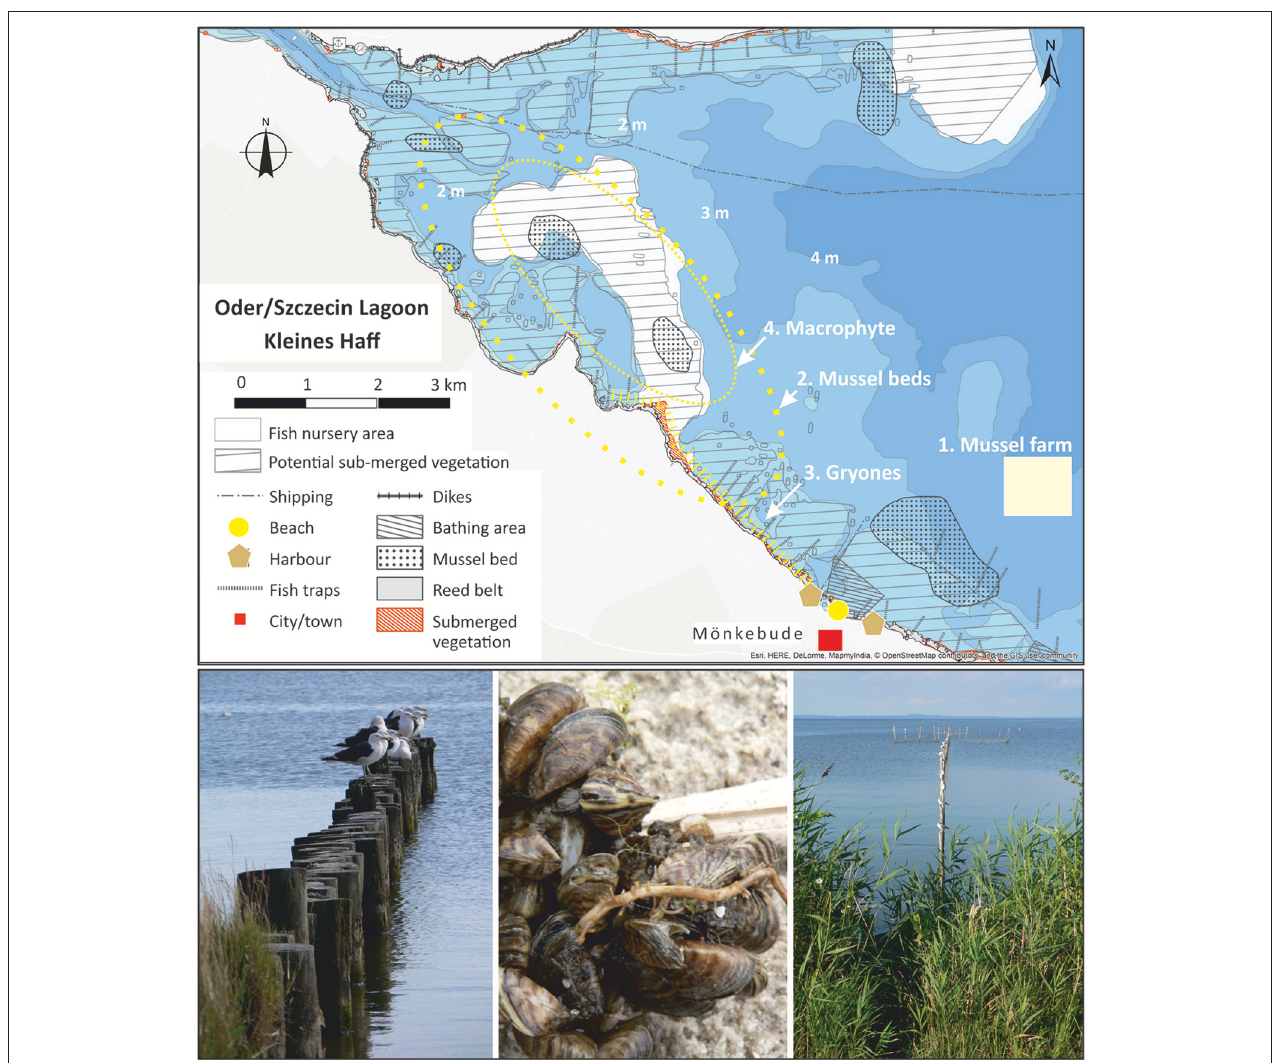
FIGURE 2 | Map of the south-western lagoon (Kleines Haff) indicating the location of major human activities and the 4 scenarios. Pictures of the south-western lagoon: Goynes (pile rows), Zebra mussels ( Dreissena polymorpha ) attached to reed and the reed belt with a fish